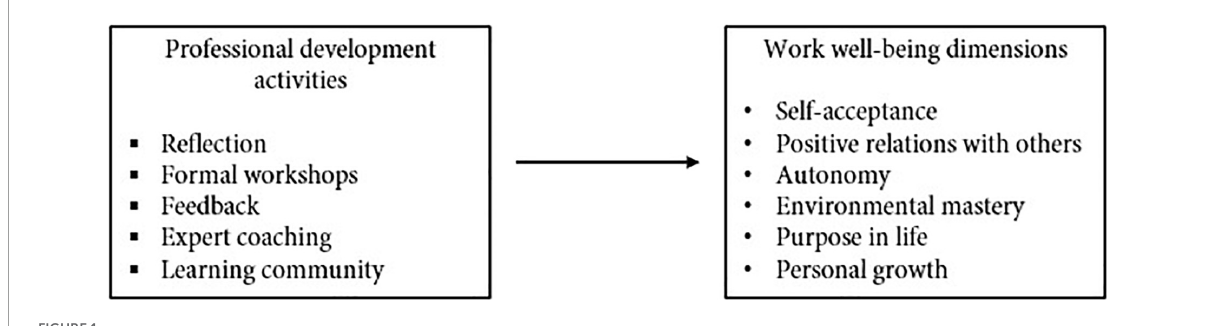
FIGURE1 Research